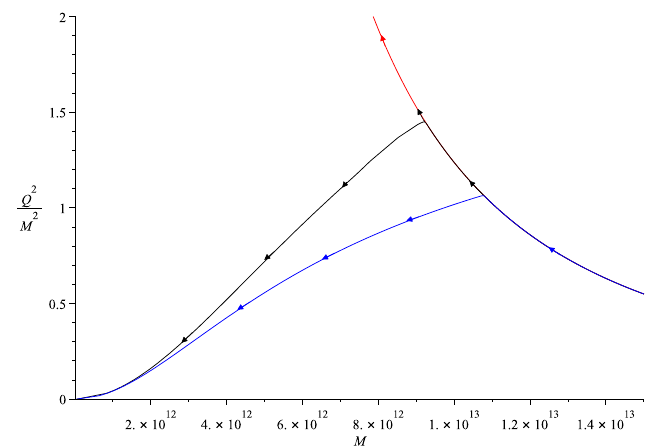
Figure 4 . GHS black hole evolution with initial conditions M (0) = 1 : 5 (cid:2) 10 13 cm, Q (0) = p 0 : 55 M (0). The curves, from top to bottom (red, black, blue), correspond to the choice C = 0 ; 1 ; 2, respectively, in the charge loss formula eq. (4.1). Arrows denote the direction of